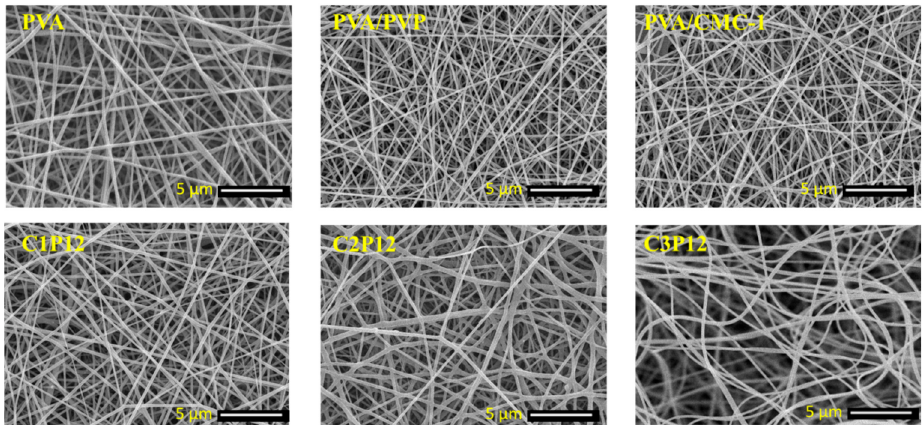
Figure 2. Scanning electron microscopic images of PVA, PVA/PVP, and tricomponent PVA/PVP/CMC nanofibers (each SEM image has a navigation bar that shows that the scale bar for all specimen was 5000 nm and acceleration energy was 10